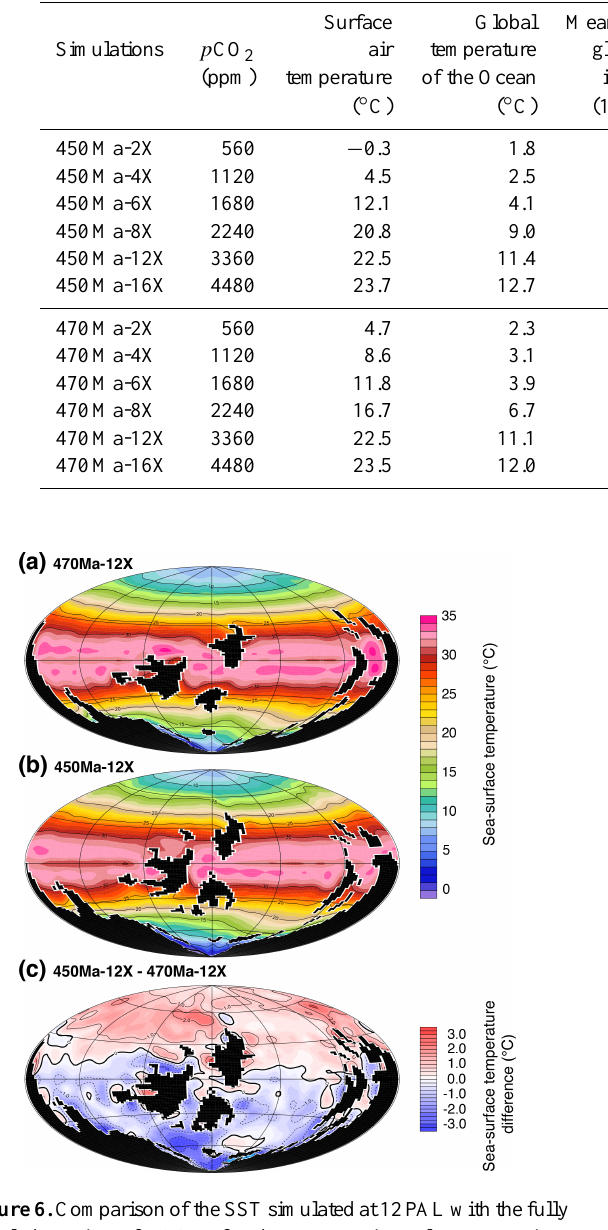
Table 1. Overview of the coupled simulations. The name of each experiment includes the age of the paleogeography used in input followed by the p CO 2 expressed inPAL. These abbreviations are used throughout the manuscript. Slab runs are not shown.